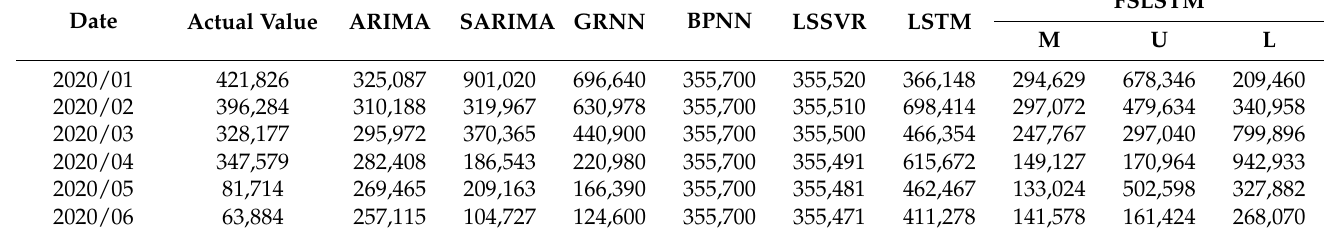
Table 6. Comparison of the forecasting results for the Taichung wind power plant.